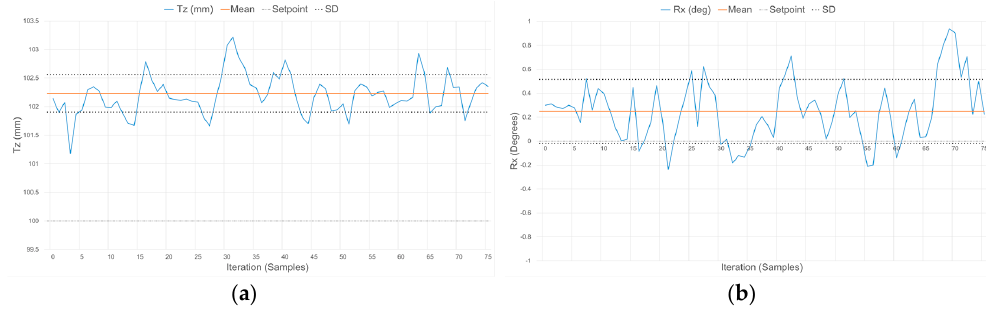
Figure 25. Response of the compliant wrist operating in proximity mode while measuring: (a) distance